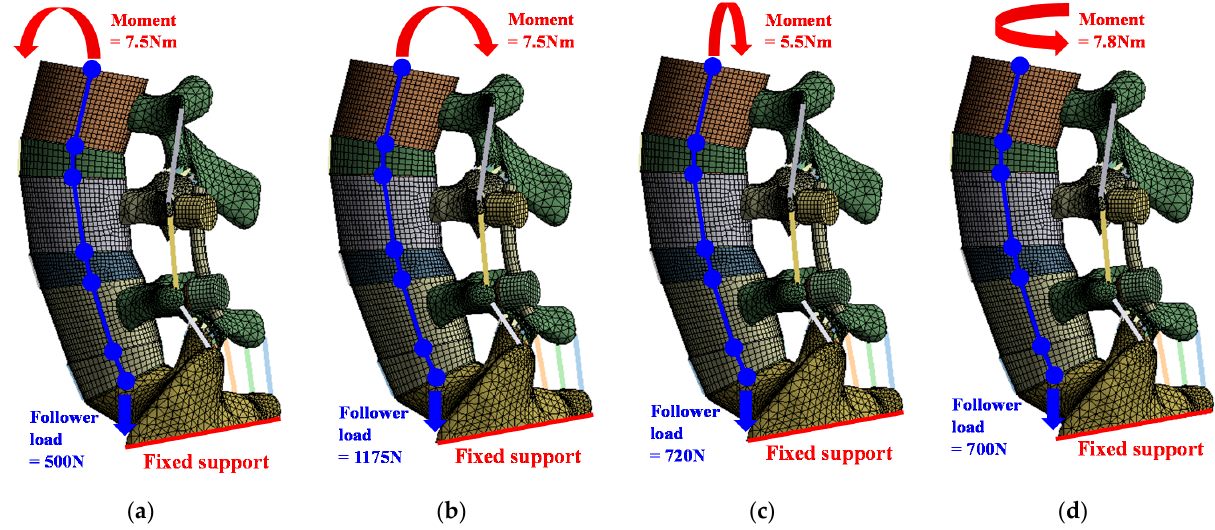
Figure 2. Loading and boundary conditions for simulation of six spinal motions: ( a ) flexion; ( b ) extension; ( c ) lateral bending; ( d ) rotation.